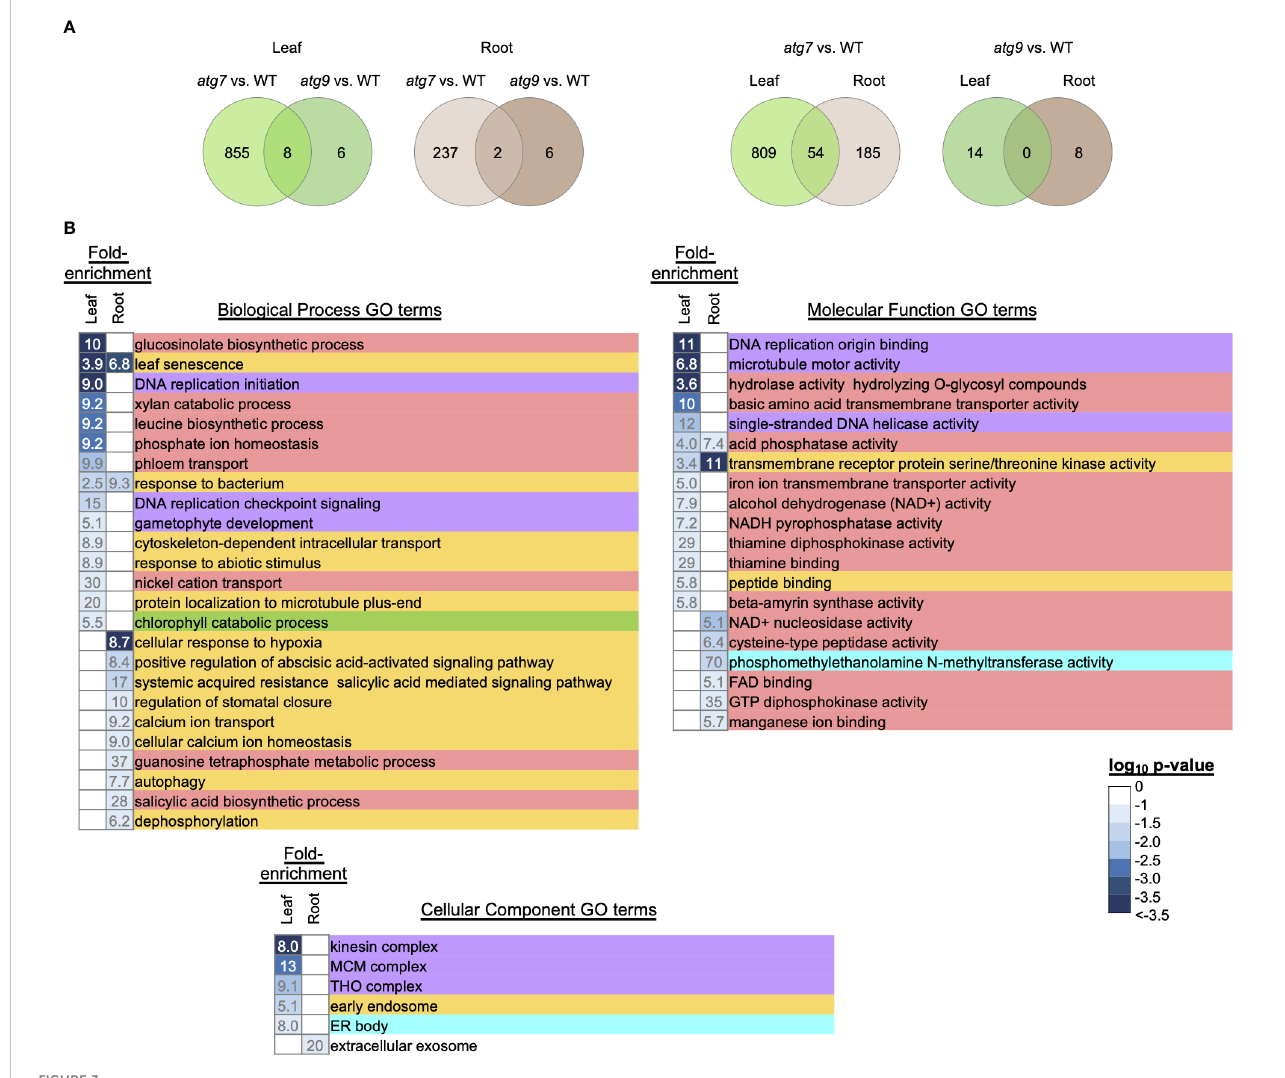
FIGURE 3 GO enrichment analysis of genes that are differentially expressed upon alterations in autophagy. DEGs that are responding to the alteration in autophagy were identi fi ed by the strategy described in Supplemental Figure 3. Venn diagrams identify the overlap of the autophagy responsive DEGs that were due to the atg7 or atg9 mutations in either leaves or roots (A) . The leaf and root GO terms showing >5-fold enrichment were identi fi ed by using the list of autophagy responsive DEGs that were responding to the atg7 mutation (B) . The intensity of the blue color shading of the fold-enrichment data is proportional to the log 10 p-value for each GO term as determined by DAVID. Each GO enrichment term is color coded to indicate higher level functional category associated with metabolism ( ■ ), DNA replication ( ■ ), signaling ( ■ ), photosynthesis ( ■ ) and lipid metabolism ( ■